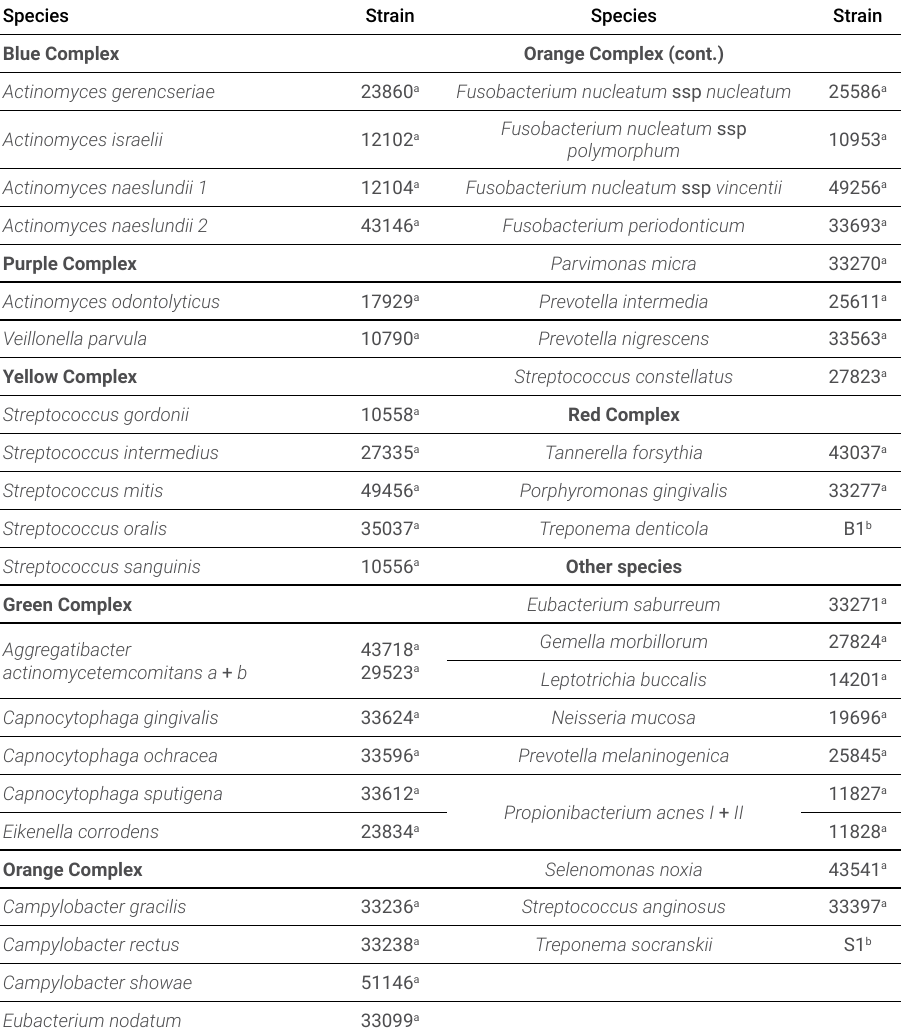
Table 1. List of the bacterial strains used for the preparation of DNA probes. The species are grouped by bacterial complexes. 6,17 Species Strain Species Strain Blue Complex Orange Complex